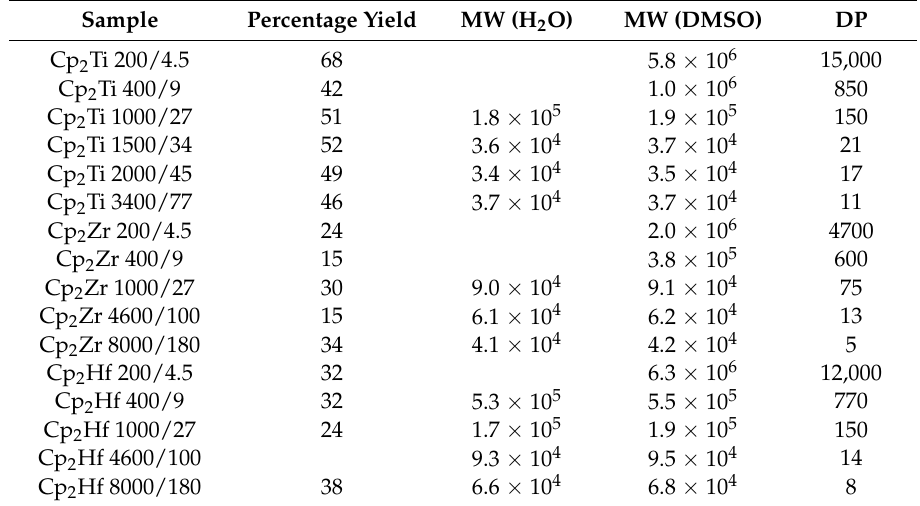
Table 4. Product yield and molecular weight as a function of PEG length and metallocene. Cp: cyclopetadiene group; MW: molecular